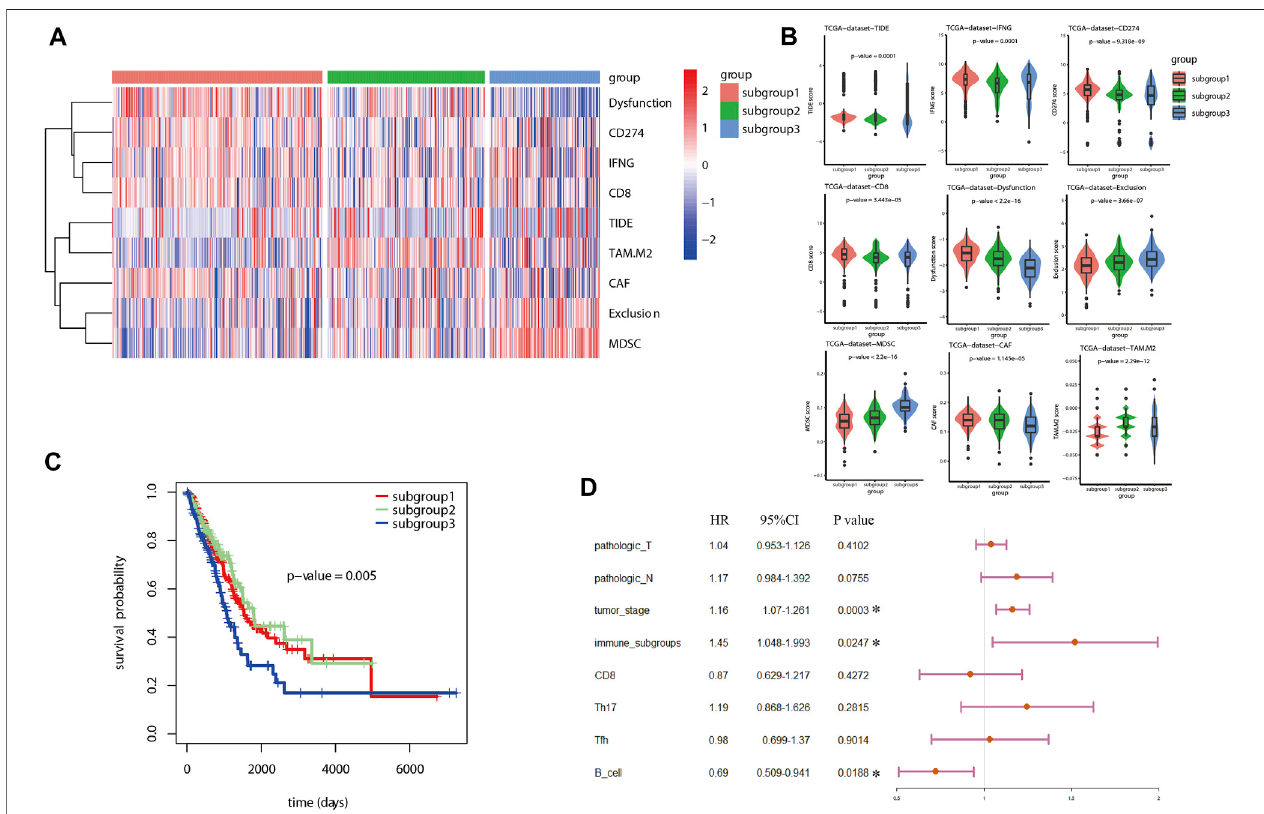
FIGURE 4 | TIDE analysis and survival analysis for LUAD based on immune related subgroup clustering. (A) TIDE analysis was used to evaluate the potential sensitivitytoICB therapyforLUADpatients.Asshown intheheatmap,theTIDEanalysisassociatedscoresweresigni fi cantlydifferentbetweenthethreesubgroups( p < 0.05). (B) Based on the TIDE analysis, a higher potential sensitivity to ICB therapy was suggested for subgroup 1 which was with higher scores for TIDE, dysfunction, CD8 + cells and interferon- γ (IFN- γ ), but with lower scores for exclusion, M2 macrophage and MDSC in comparison with that in subgroup 3. (C) Kaplan Meier analysiswasperformedtoestimatethesurvivalofLUAD.Asshown,subgroup3tendedtohaveanunfavorableprognosisincomparisonwithsubgroup1andsubgroup 2. (D) Atotalof8factorswereincludedinfurthermultivariateCoxproportionalhazardsregressionanalysistoidentifyindependentriskfactorsforLUADafteranunivariate Cox proportional hazards regression analysis. As shown in the forest plots, immune associated subgroup clustering, tumor stage and B cells in fi ltration were suggested as potential independent factors in fl uencing overall survival (OS) of LUAD ( p < 0.05).